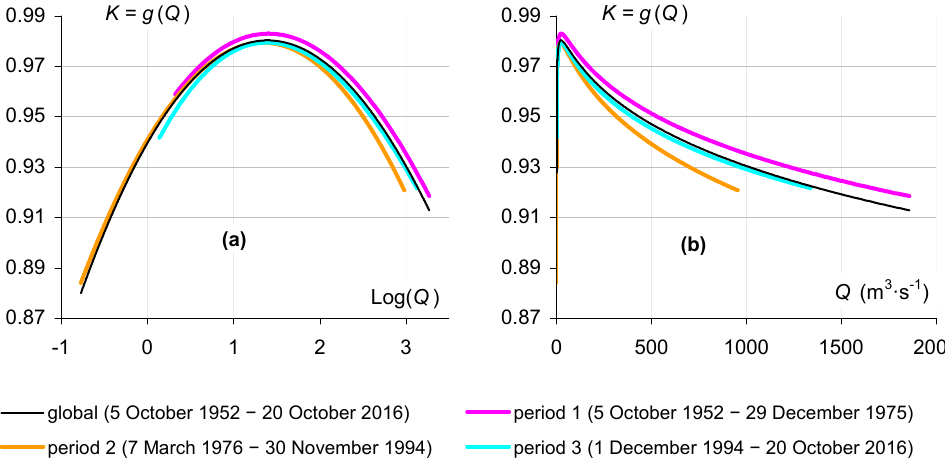
Figure 14. Model 2 representing K as a function of discharge Q , calibrated on successive periods 1 to 3 and on the overall period, for the Bafing at Daka Saidou (station 8), with abscissa in logarithmic values on the left ( a ) and natural values on the right ( b